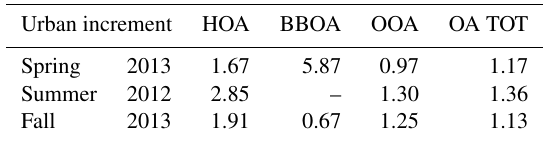
Table 3. Urban increment, calculated as the ratio between the cam- paign average concentration at the urban and rural sites, for each season and OA fraction